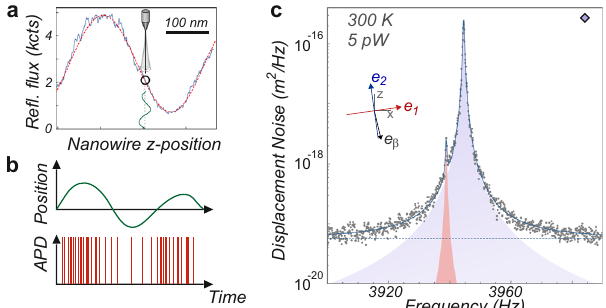
Fig. 2 Nano-optomechanical readout in the photon counting regime. a When the nanowire is placed at a position presenting a large spatial variations of the re fl ected fl ux, its position fl uctuations are converted into a large fl ux modulation ( b ). The SNR can be improved by working in the lower part of the interference slope, to reduce the shot-noise level. c Typical thermal noise spectrum (nanowire A) obtained at room temperature with ≈ 5 pW of injected light, used to determine the effective mass (16 pg) and the eigenmodes orientations (inset) of both nanowire transverse fundamental